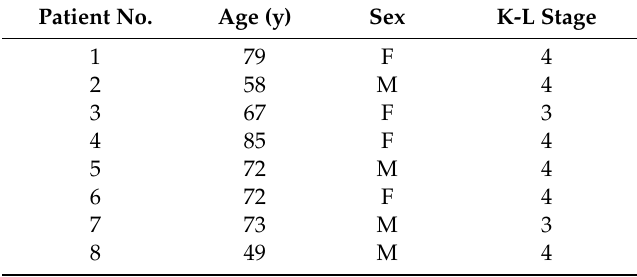
Table 1. Patient age, sex and Kellgren–Lawrence (K-L) grades based on X-ray imaging. Patient No. Age (y) Sex K-L Stage 1 79 F 4 2 58 M 4 3 67 F 3 4 85 F 4 5 72 M 4 72 F 73 M